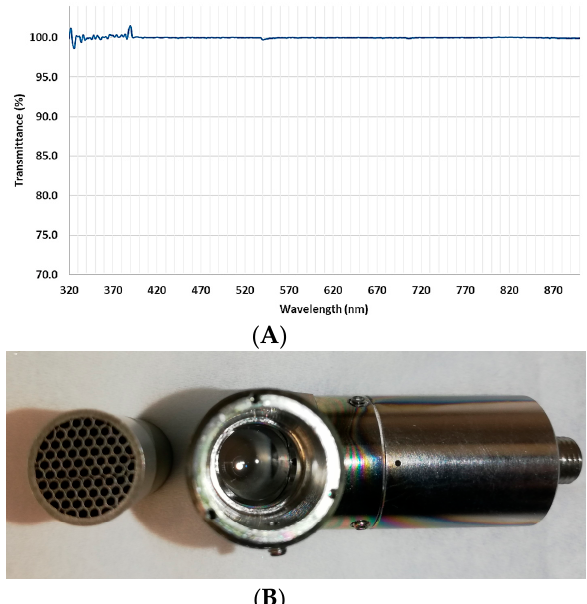
Figure 2. ( A ) In-vacuum collimator optics was placed adjacent to the magnetron and the emission data were transferred to the spectrometers via quartz fiber, the distance between the collimator and target edge was 4 cm. ( B ) The Collimator.